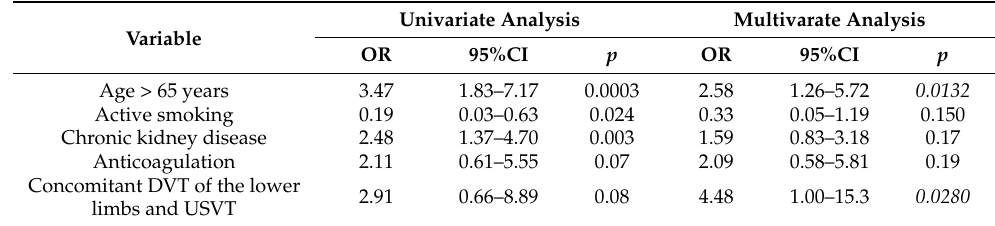
CI: confidence interval; DVT: deep vein thrombosis; OR: odds ratio; USVT: unusual site venous